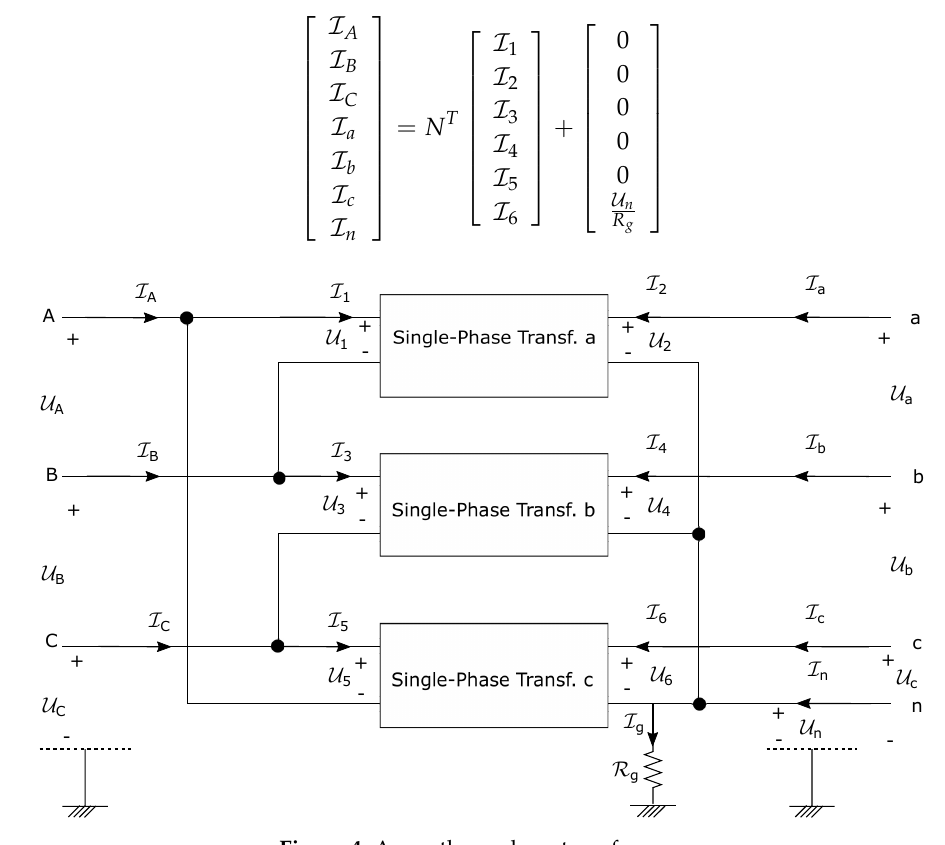
Figure 4. ∆ − yg three-phase